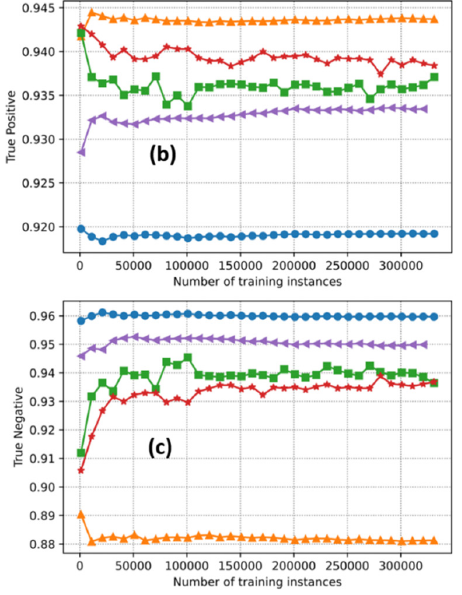
Figure 5. The performance evaluation of different training models: the relationship between the number of training instances and ( a ) the test set overall accuracy, ( b ) true positive rate (accuracy of sea water discrimination), and ( c ) true negative rate (accuracy of sea ice discrimination). The blue, orange, green, red, and purple marked-lines represent the results from Naive Bayes, logistic regression, random fore gradient boosting, and support vector machine (SVM) classification,